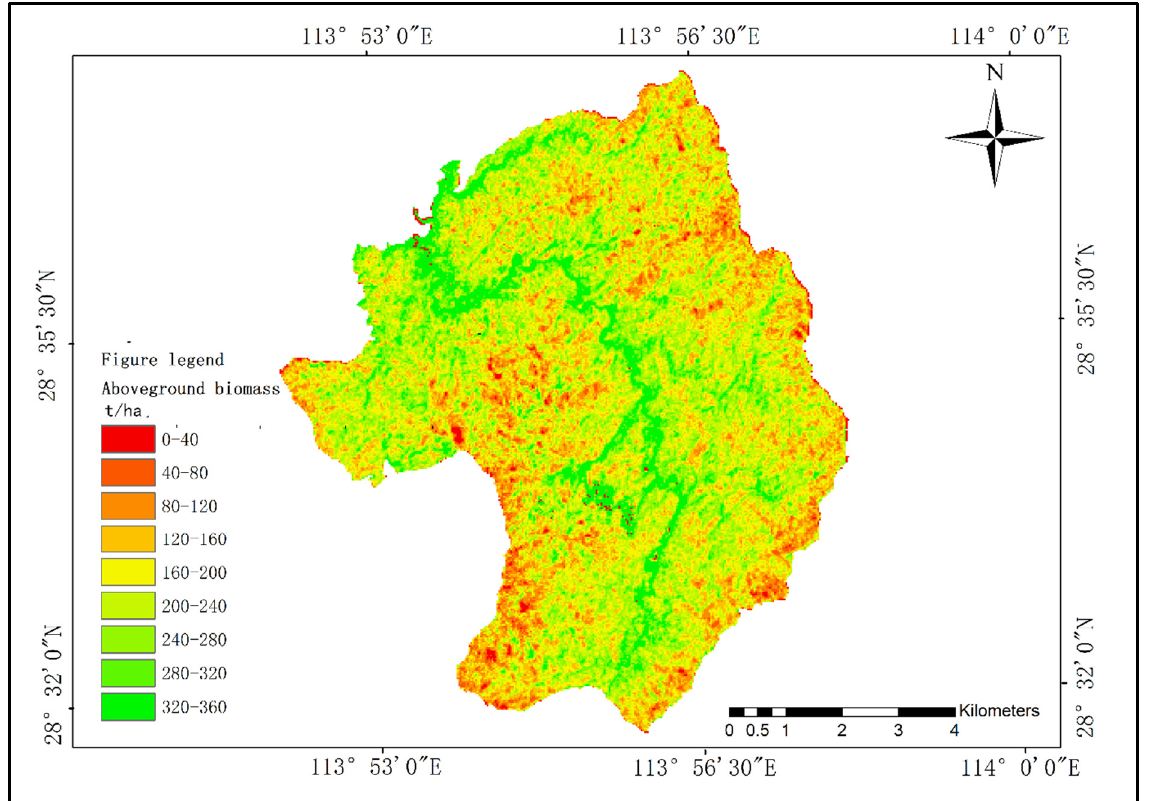
Figure 8. Forest aboveground biomass distribution of the Lutou Forest Farm.